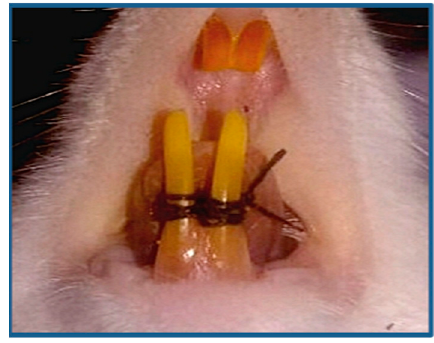
Figure 1. This figure shows the figure eight ligature around the lower